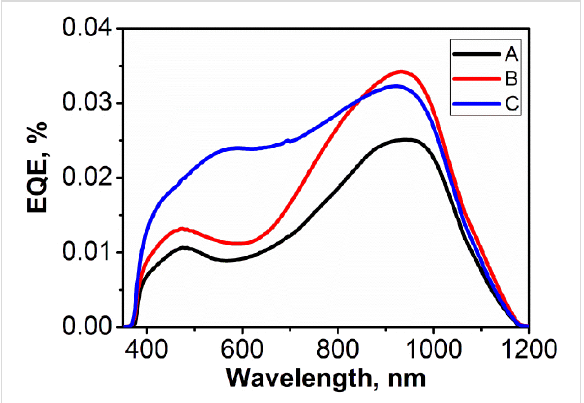
Figure 5 shows the external quantum efficiency measured with (2) an illumination in the range of 350–1200 nm. The investigated PV structures react to the light from 380 nm to 1150 nm. For all samples the highest value of generated photocurrent flows through the junction with an illumination in the range of 900 nm to 1000 nm, i.e., when carriers are generated in a Si substrate. Samples with a similar value of the shunt resistance (A, B) have a similar photoresponse curves. Quantum effi- ciency values calculated at 950 nm for the samples A, B and C are 2.51 × 10 − 2 %, 3.39 × 10 − 2 % and 3.17 × 10 − 2 %, respective- ly. The quantum efficiency of structure C, the one with the highest efficiency, is twice as large as for the samples A and B when illuminated with light in the range of 350 nm to 700 nm. This may be explained by the increased absorption of ZnO